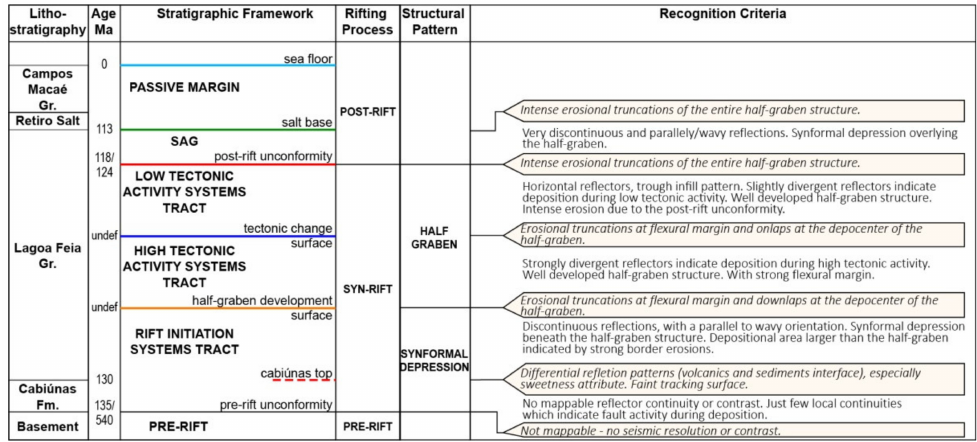
Figure 8. Chart of the stratigraphic framework in the Campos Basin rift, relating the lithostratigraphy data, general age of surfaces, surfaces defining the systems tract framework, rifting process, structural pattern and the recognition criteria of the observed units and